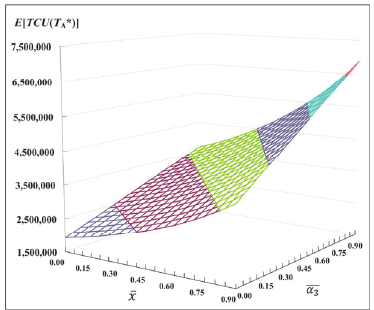
Fig. 9. Investigative result on distinctive cost elements in the proposed FPR-based system